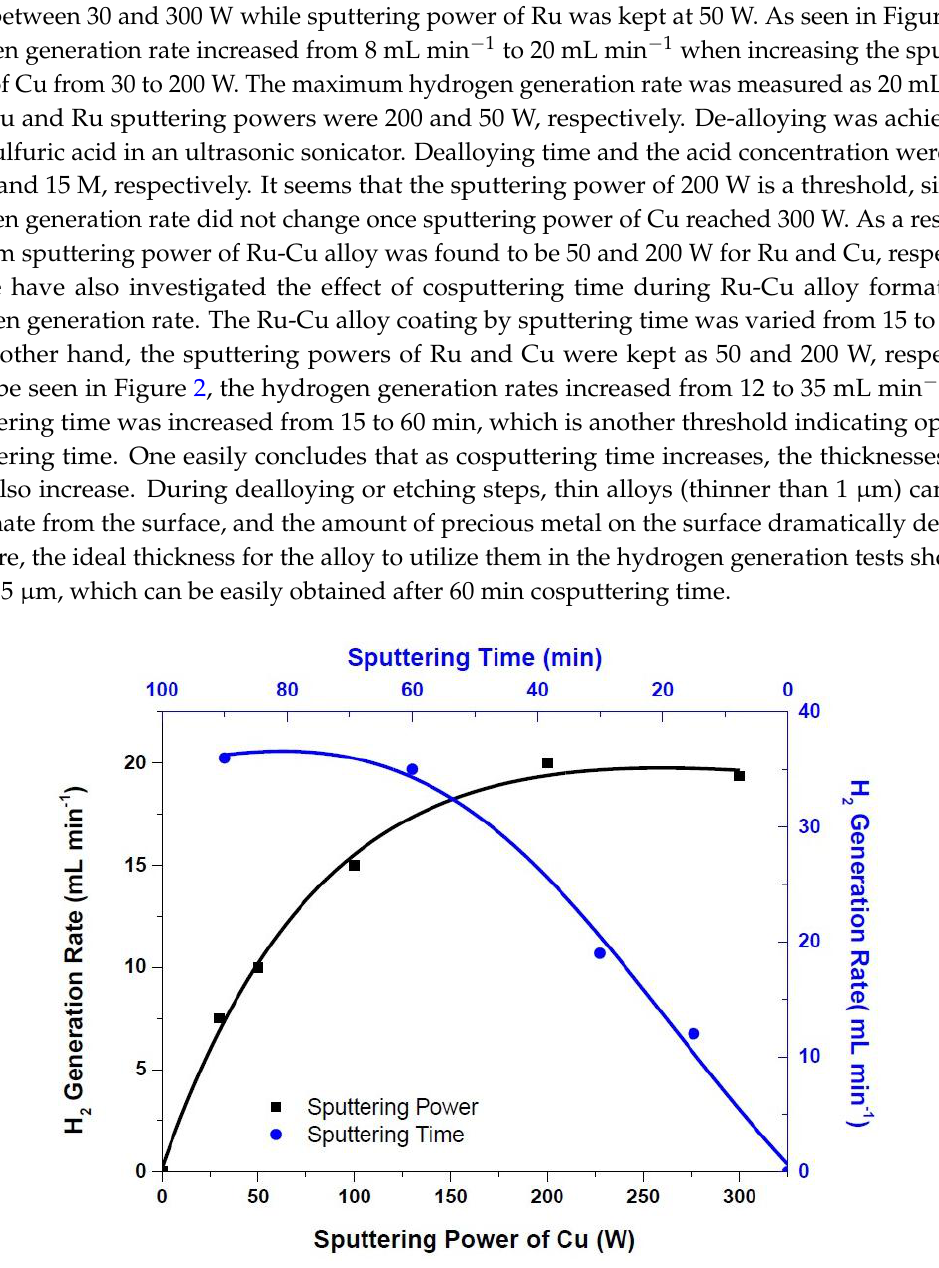
Figure 2. Influence of sputtering power (sputtering and dealloying time and the acid concentration are both 60 min and 15 M, respectively) and sputtering time of Cu (the sputtering powers of Ru and Cu were kept as 50 and 200 W, respectively, dealloying time was 60 min, and the acid concentration was 15 M ) on hydrogen generation rates.